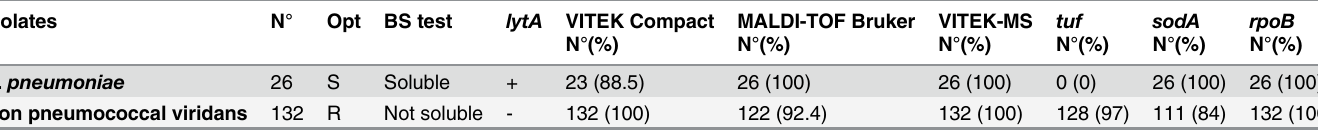
Table 2. VGS isolates phenotypic and identi fi cation results.